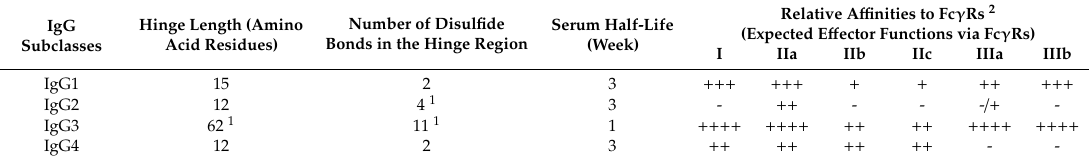
Table 1. Molecular properties of IgG antibody